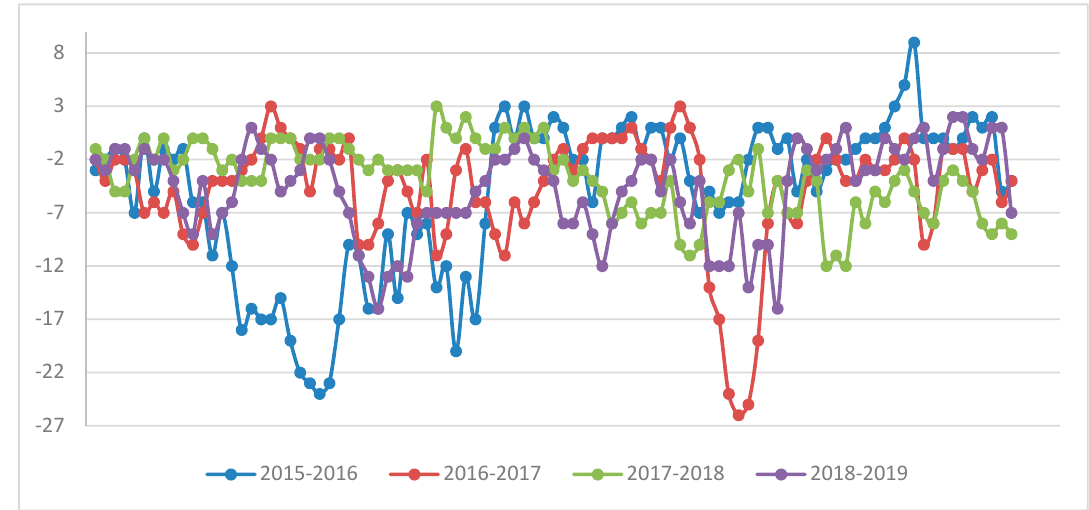
Figure 3. Temperature measurement from November to March of each year on the territory of the city of Valday.